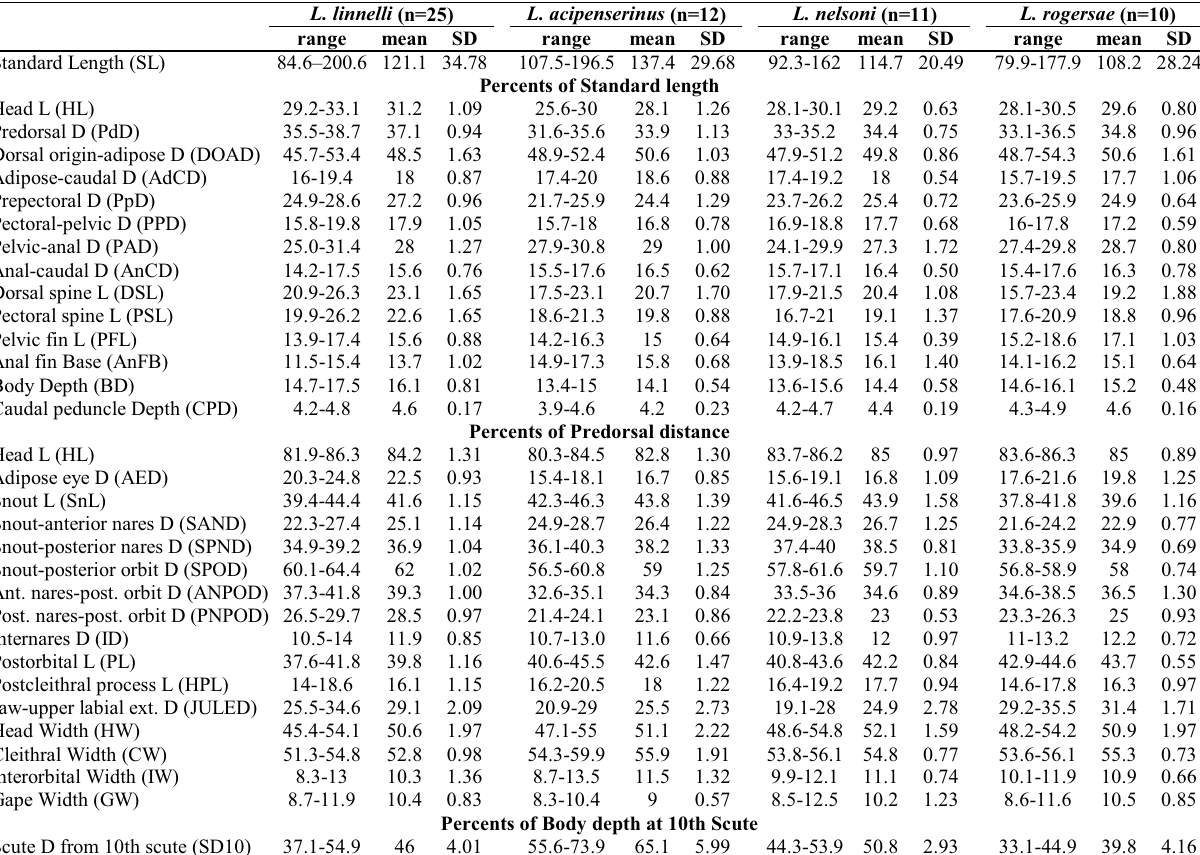
Table 1. Morphometrics of Leptodoras linnelli , L. acipenserinus , L. nelsoni , and L. rogersae . Measured specimens denoted with asterisk in material